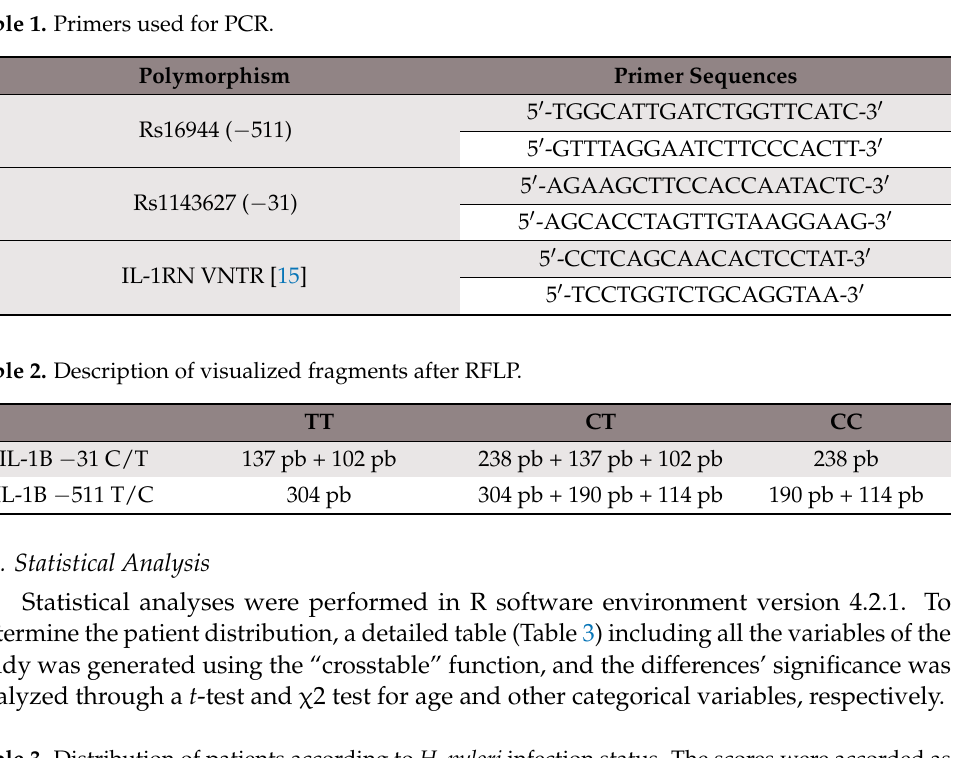
Table 3. Distribution of patients according to H. pylori infection status. The scores were accorded as reported in the Sydney classification